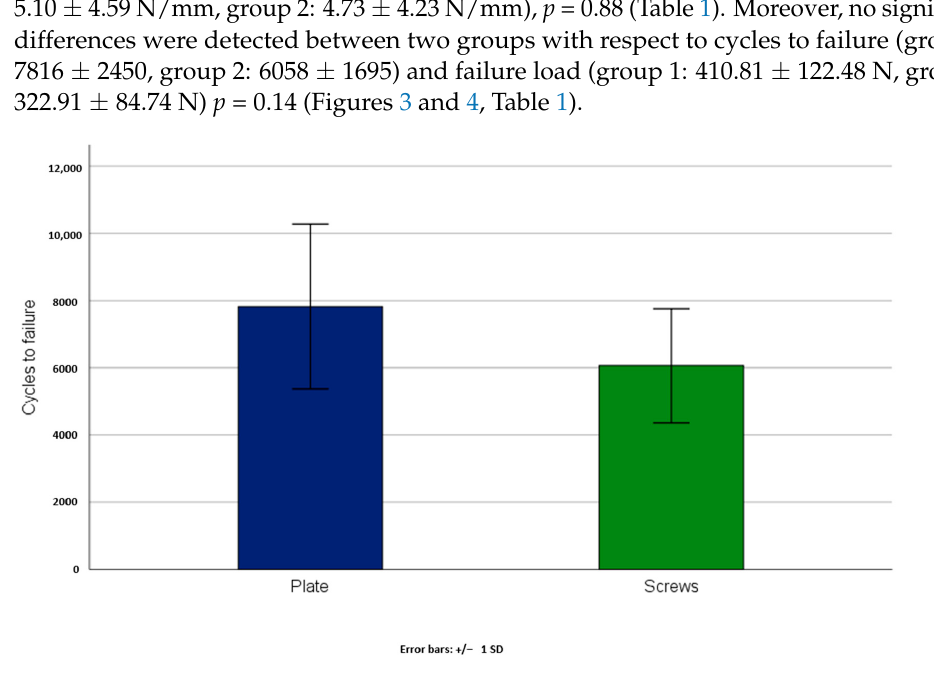
Figure 3. Cycles to failure in group 1 (Plate) and group 2 (Screws) presented in terms of mean value and standard deviation, with no significant difference between the groups, p = 0.14.